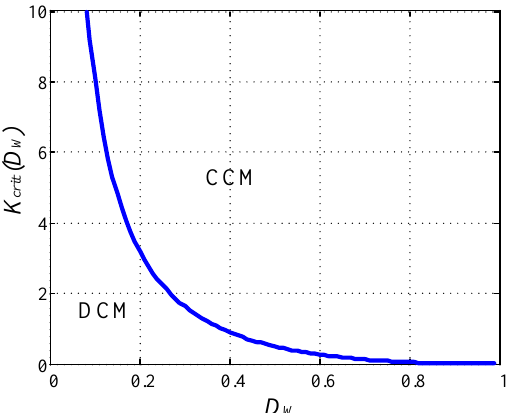
Figure 13. Proposed step up / down AC / DC converter K cirt ( D w ) vs. D w .